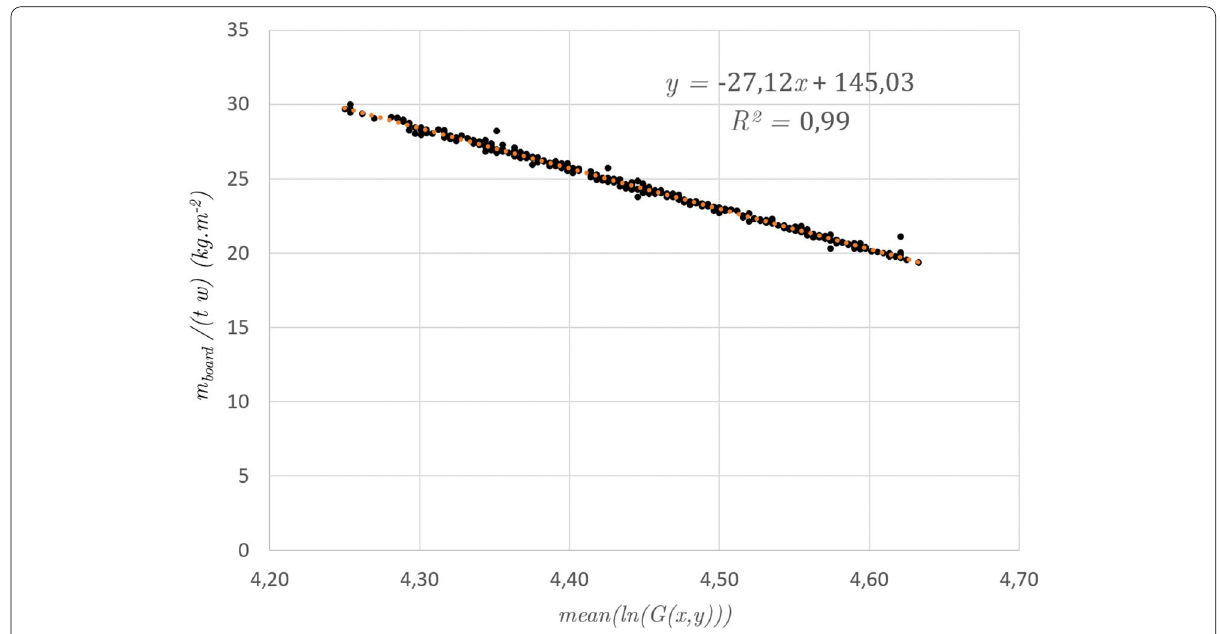
Fig. 11 Calibration of the local density from X‑ray